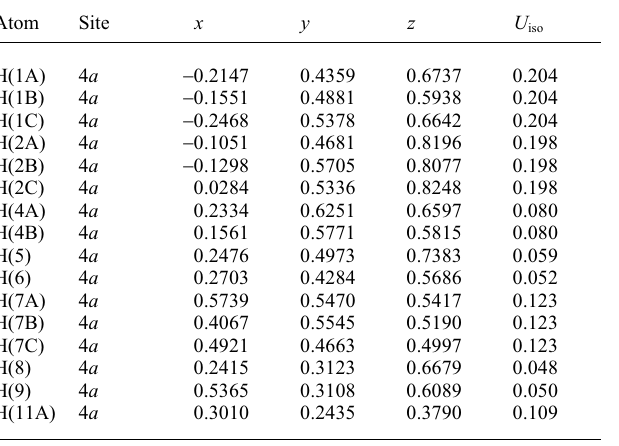
Table 2. Atomic coordinates and displacement parameters (in Å 2 )